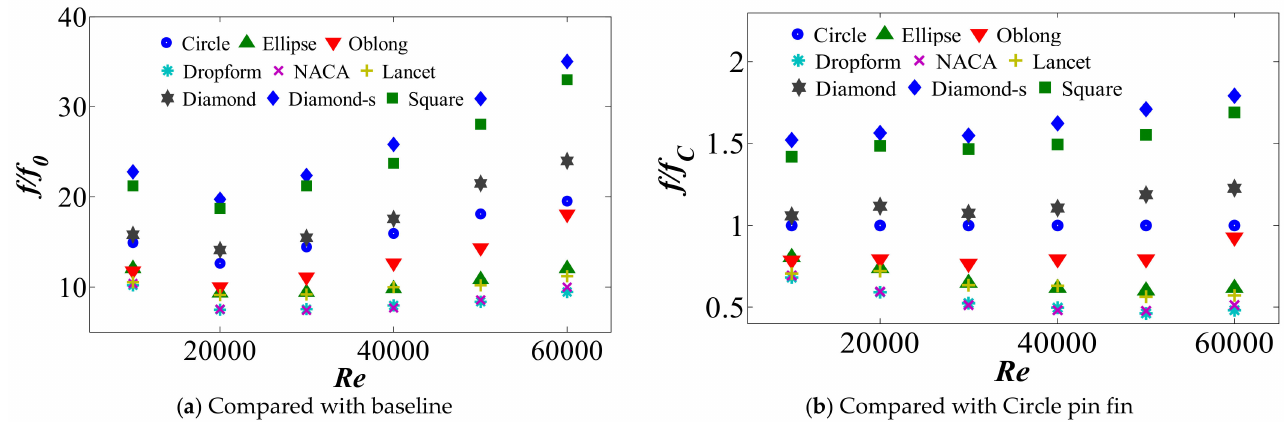
Figure 13. Friction factor comparison of different pin